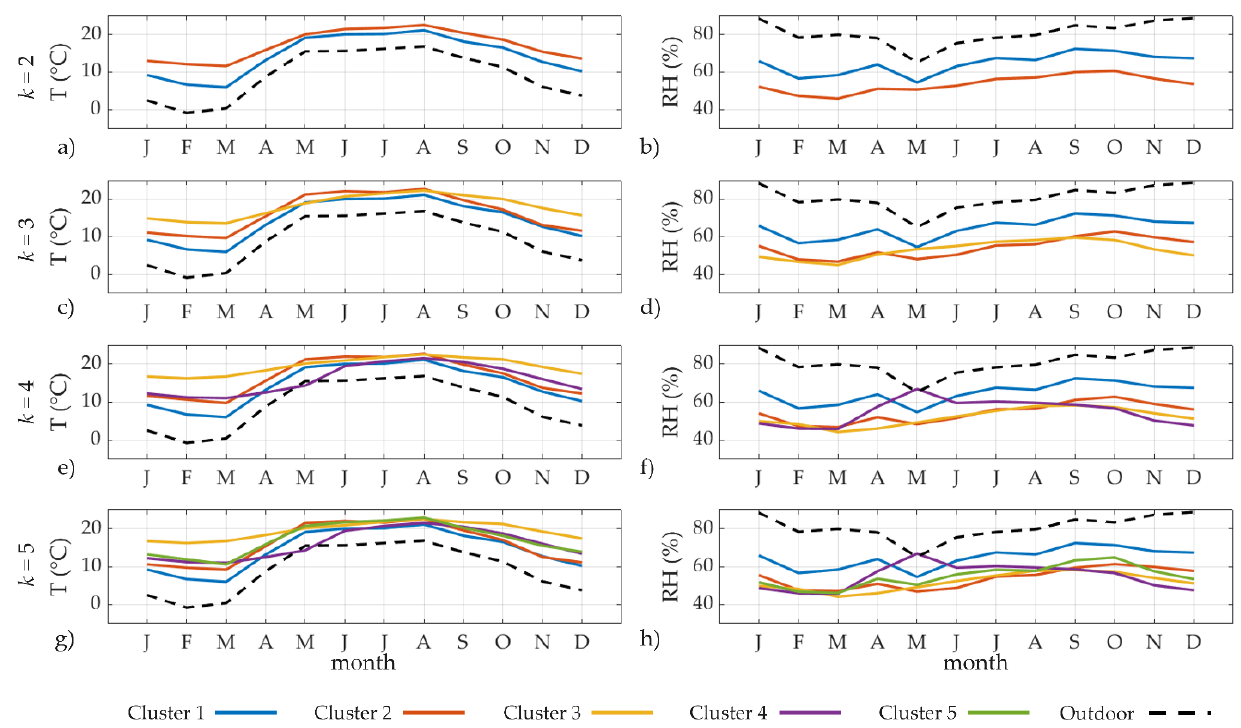
Figure 8. Time evolution of temperature (left panels) and relative humidity (right panels) in each cluster based on outcomes of different k-mean Cluster Analysis: ( a , b ) for k = 2; ( c , d ) for k = 3; ( e , f ) for k = 4; ( g , h ) for k = 5. Colour code: Cluster 1 in blue; Cluster 2 in orange; Cluster 3 in yellow; Cluster 4 in violet; Cluster 5 in green; outdoor conditions in black.